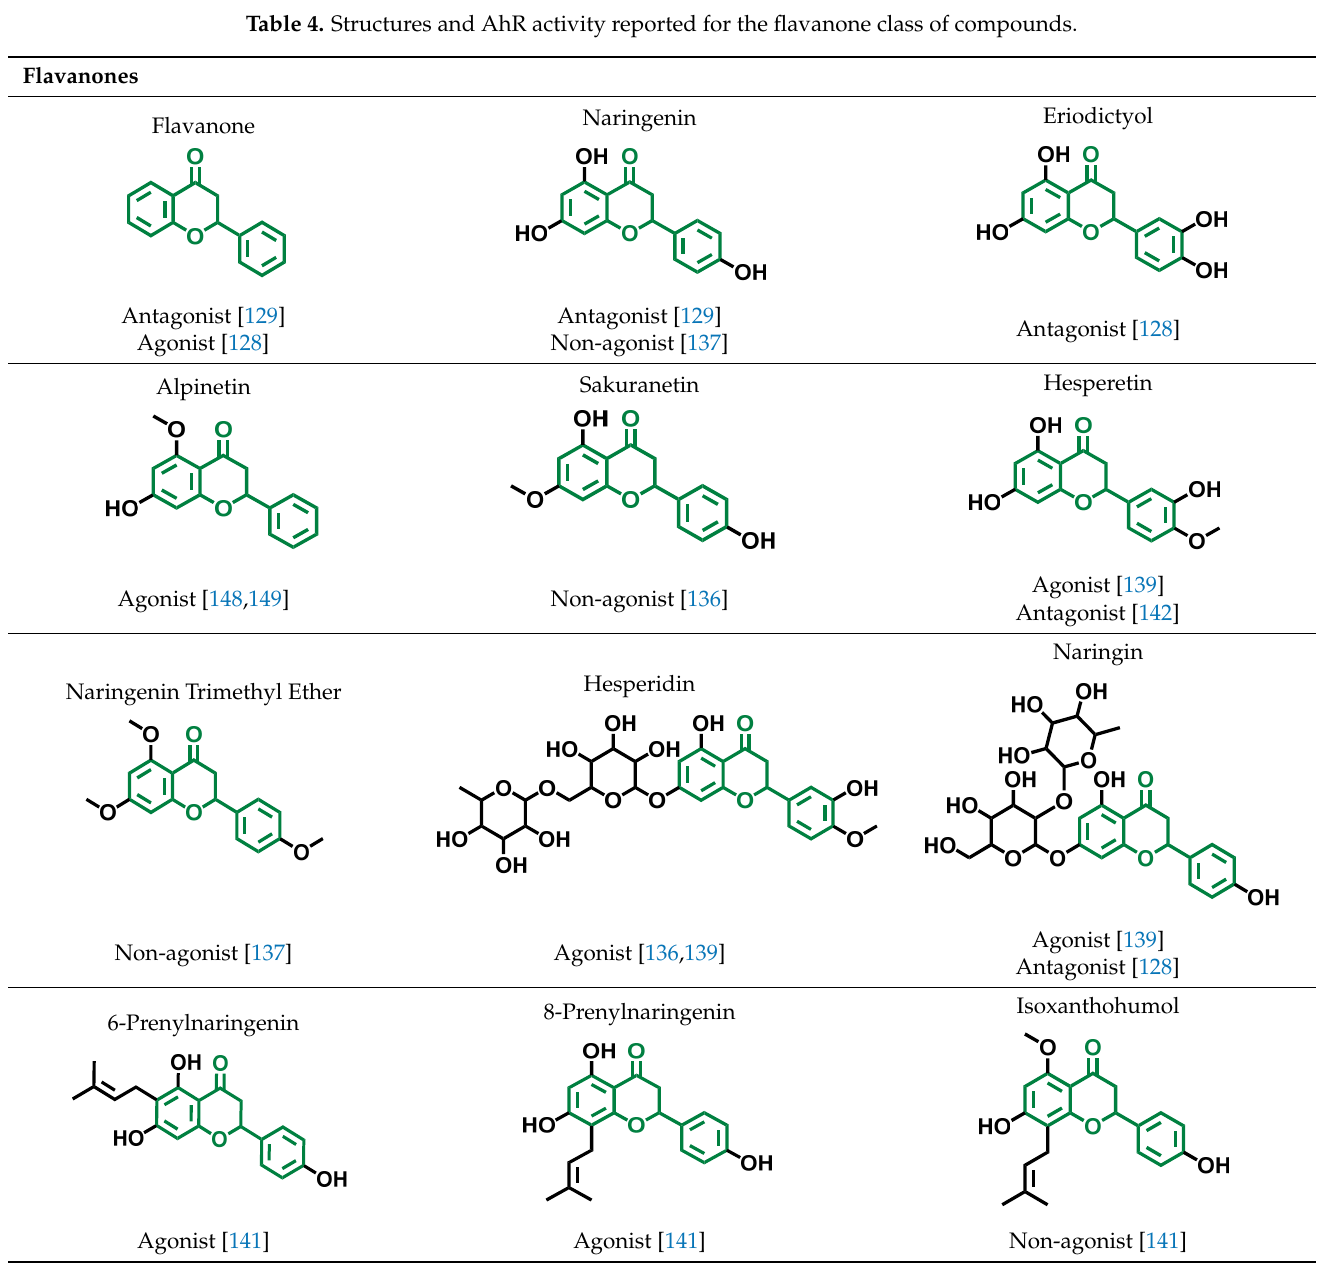
Table 4. Structures and AhR activity reported for the flavanone class of compounds.